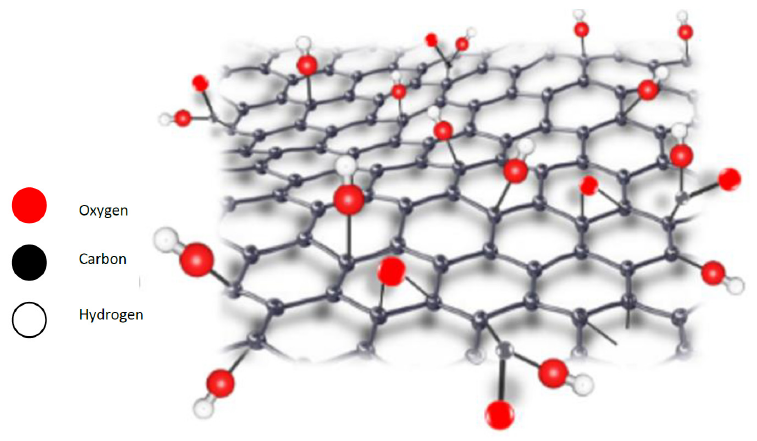
Figure 1. A representation of the 3D structure of GO.